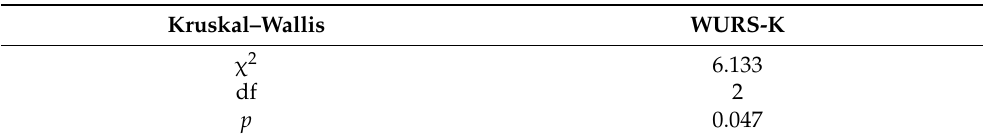
Table A8. Testing for significant group differences in the Wender Utah Rating Scale-Kurzform (WURS- K) using the Kruskal–Wallis test. Abbreviations: WURS-K, Wender Utah Rating Scale-Kurzform; df, degree of freedom; p , asymptotic significance; χ 2 , chi-square.